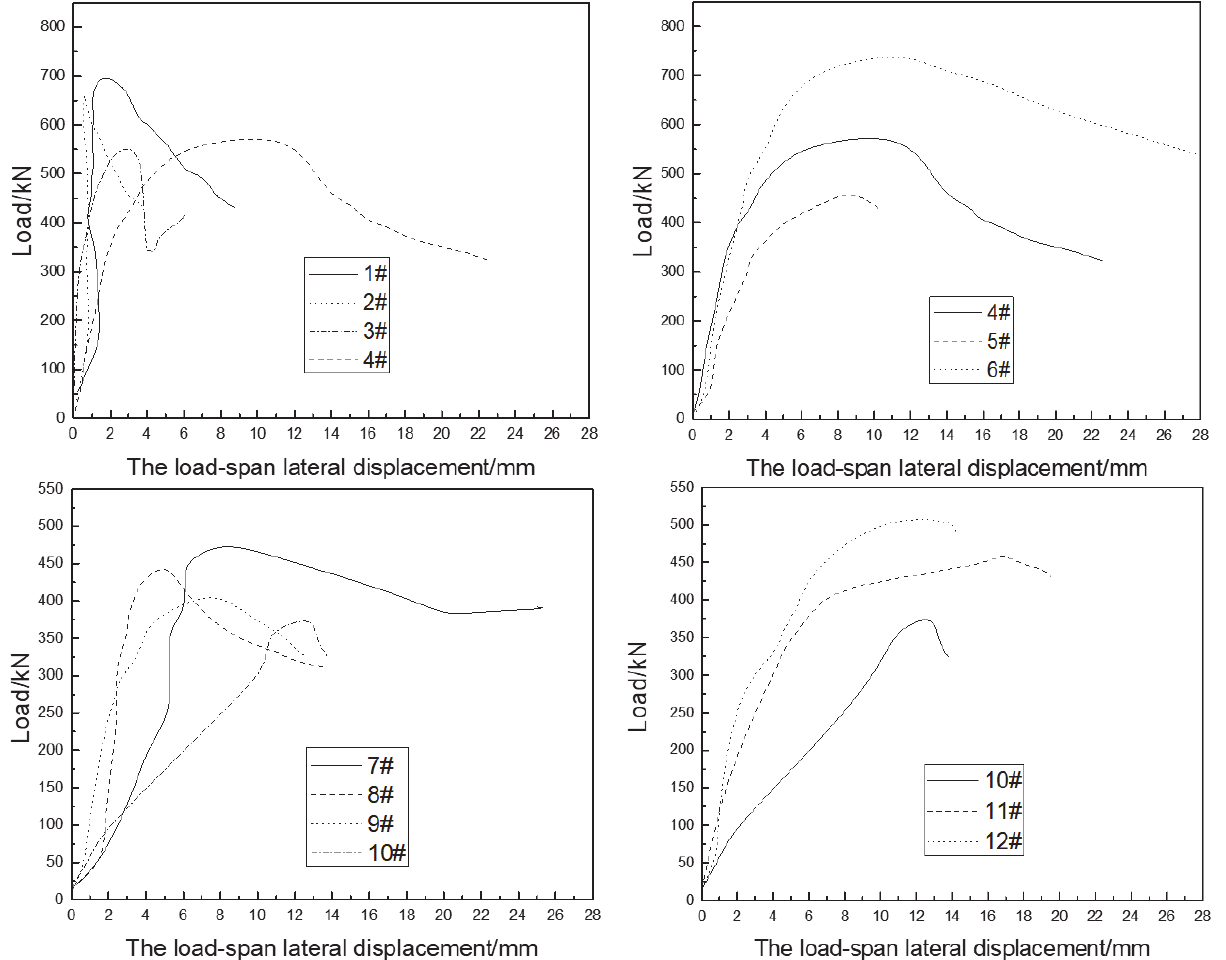
Figure 4: Load-span lateral displacement curves of the specimens.